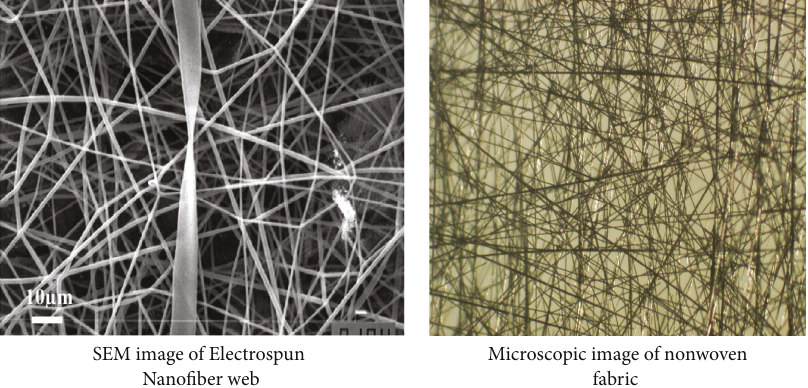
Figure 5: Nonwoven fabric images of electrospun nanofibers web [30] and nonwoven felt [31].